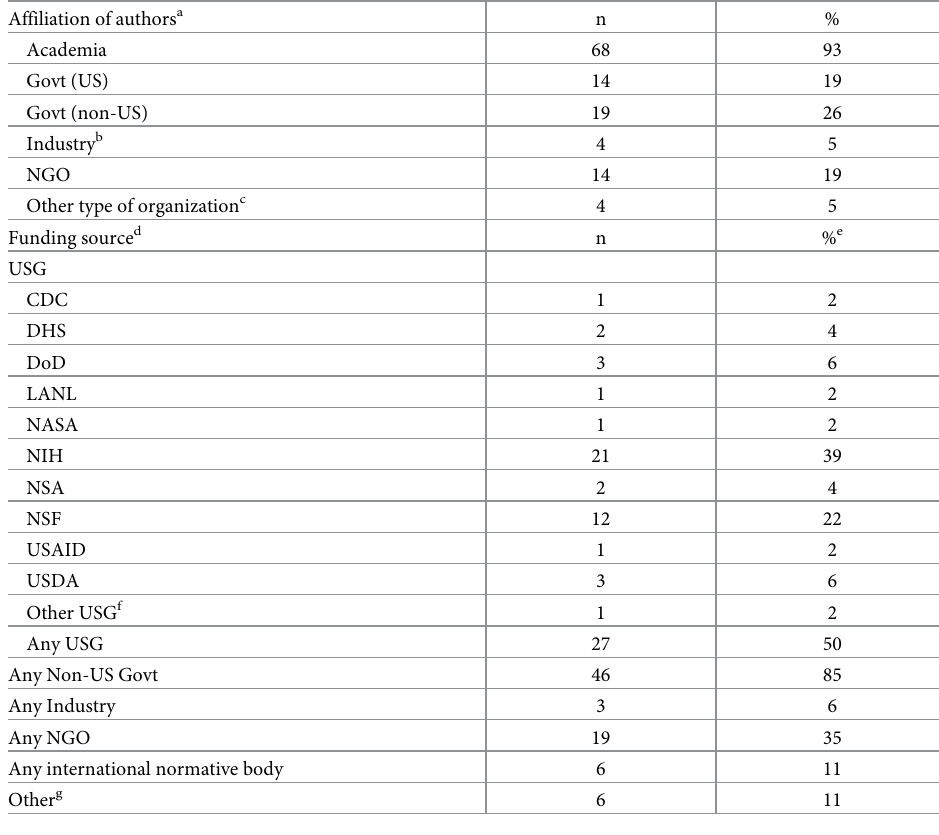
Table 4. Author affiliation and funding source of eligible